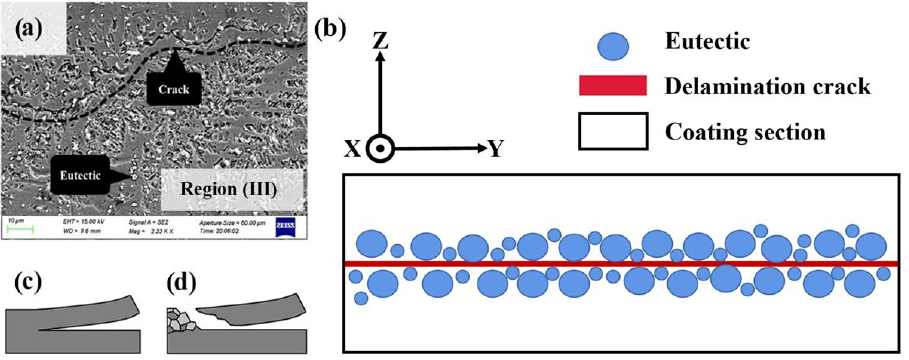
Figure 11. Delamination crack below oxide film: ( a ) dense eutectic particles and a crack in region III; ( b ) schematic of lamellar distribution of eutectic particles and a delamination crack; ( c ) delamination in the coating; ( d ) intergranular corrosion and material shedding. Table 4. EDS analysis of Sample 1600-10 after high-temperature oxidation treatment ( wt% ). Marked